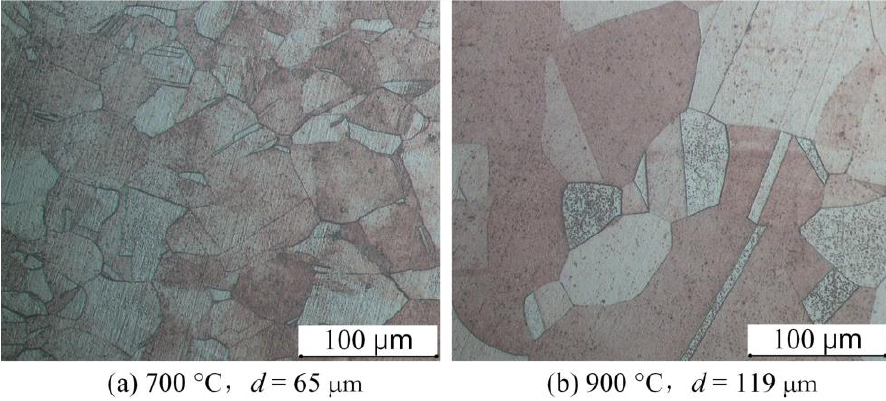
Figure 15. Metallography of pure copper specimens with different heat treatments ( a ) 700 °C, d = 65 μm , and ( b ) 900 °C, d = 119 μm.